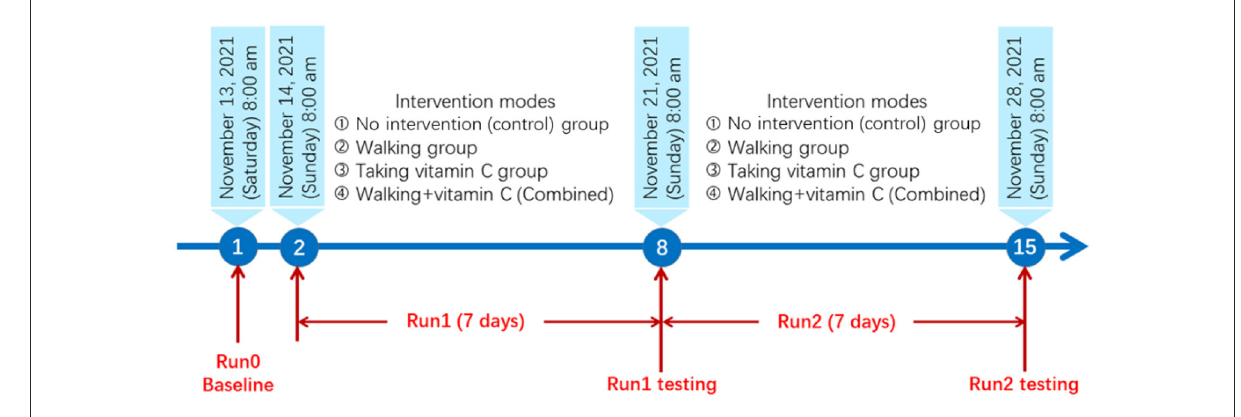
FIGURE1 The research protocol for this panel study.